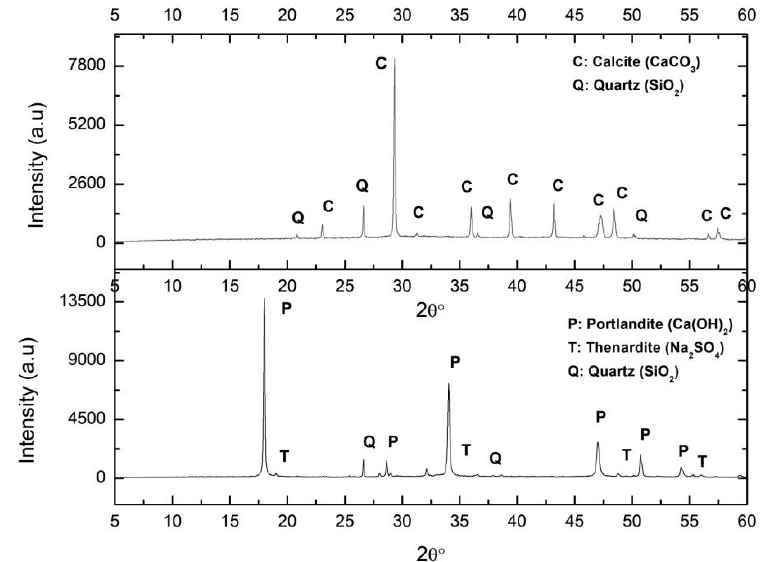
Figure 2. XRD (X Ray Diffraction of the samples Ca_S (calcite from lime putty carbonation) (above) and C_S (lime putty) (below). C: Calcite, Q: Quartz, P: Portlandite, T: Thenardite.